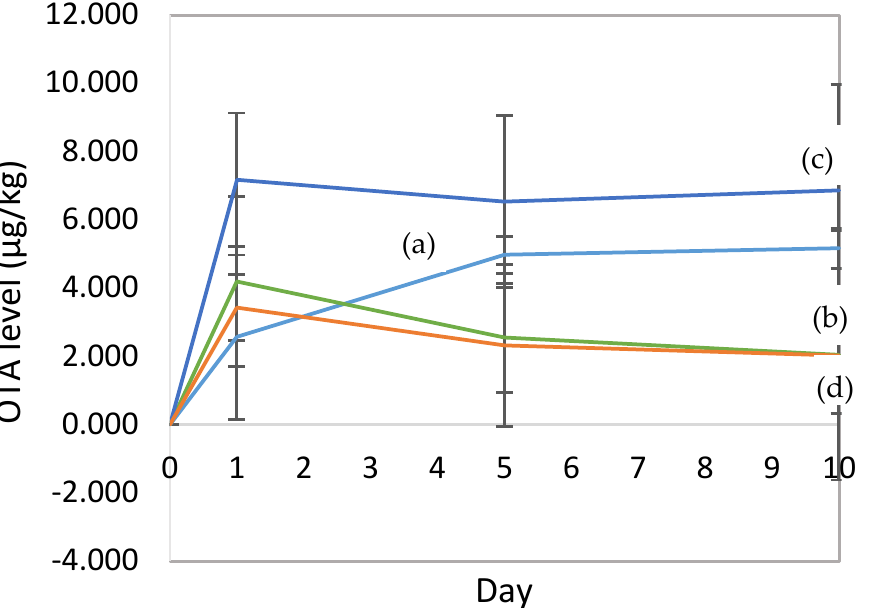
Figure 6. The OTA concentration during fermentation (days 0, 1, and 5) and drying (day 10): ( a ) natural fermentation; ( b ) fermentation of cocoa beans with the addition of L. plantarum HL-15 and A. niger YAC-9 as a contaminant; ( c ) fermentation of cocoa beans with the addition of A. niger YAC- 9 as a contaminant; ( d ) cocoa bean fermentation with the addition of a mixed starter culture consist-